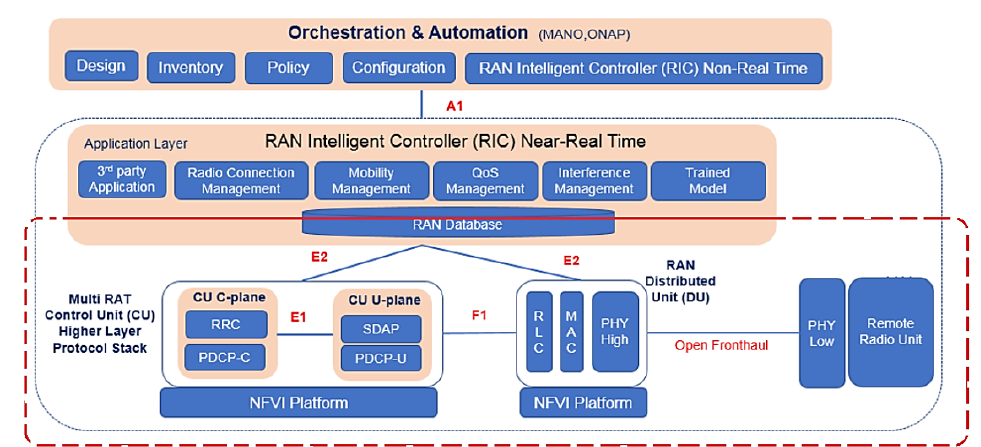
Figure 14. Architecture of CNF with applications running on O-DU/O-CU servers with OpenRange Software for vDU and vCU. Based on [58,59].